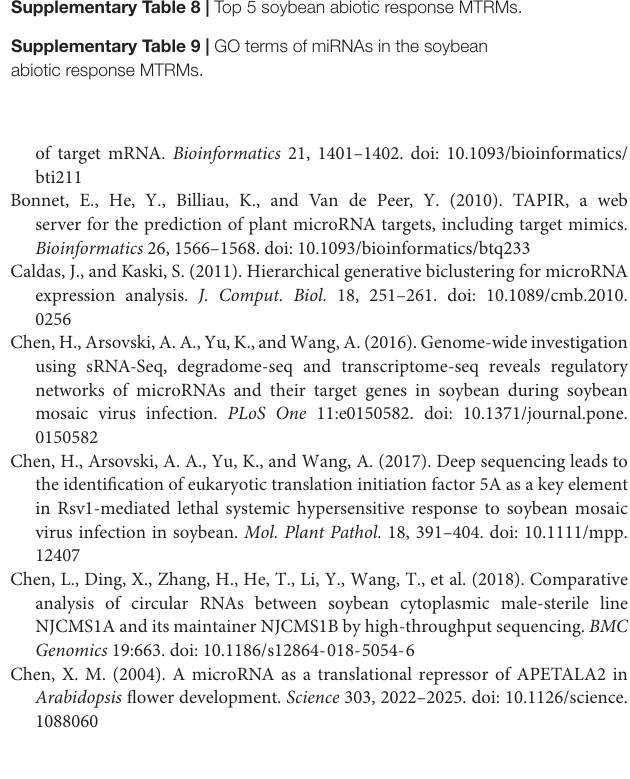
Supplementary Table 2 | Potential targets found by homology expansion. Supplementary Table 3 | Comparison of the biclustering results of soybean MTRMs. Supplementary Table 4 | The top 5 GO enrichment of each top 5 soybean MTRMs. Supplementary Table 5 | miRNA function annotation.